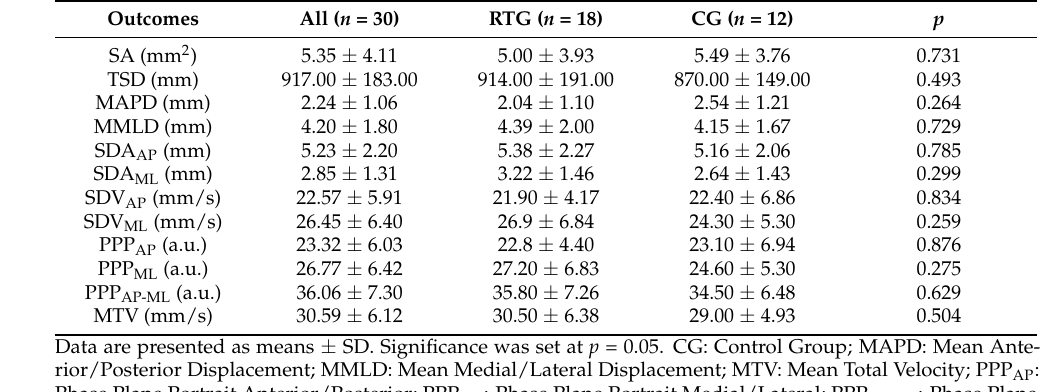
Table 2. Group comparisons of baseline measurements in eyes-open balance test.